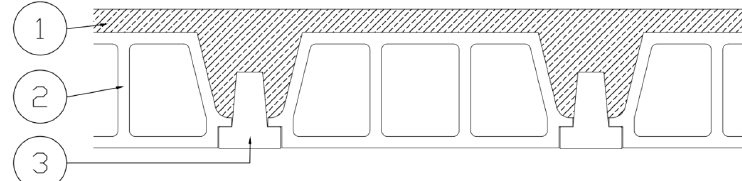
Figure 2. Cross-section of a beam and block floor (1 – concrete, 2 – hollow blocks, 3 – beams).